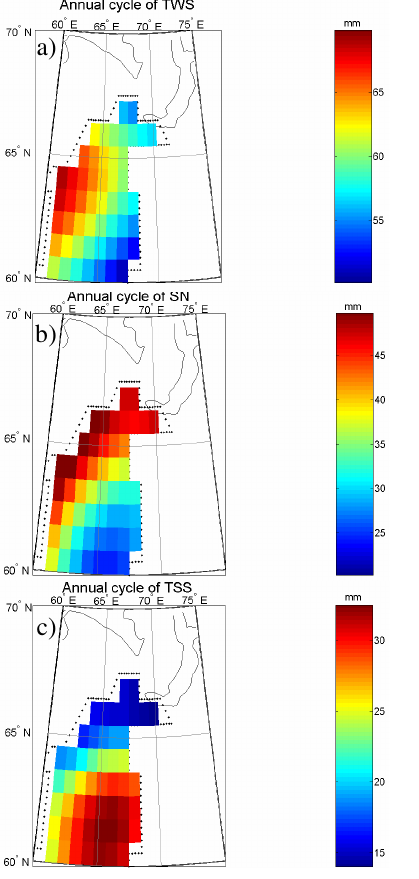
Figure 8. Amplitude of the annual cycle over 2003-2004: a) TWS from GRACE, b) Snow 24 Fig. 8. Amplitude of the annual cycle over 2003–2004: (a) TWS from GRACE, (b) snow Water Equivalent (SWE) from GRACE, Water Equivalent (SWE) from GRACE, c) Total Soil Storage. Units: mm. 25 (c) total soil storage. Units: mm.